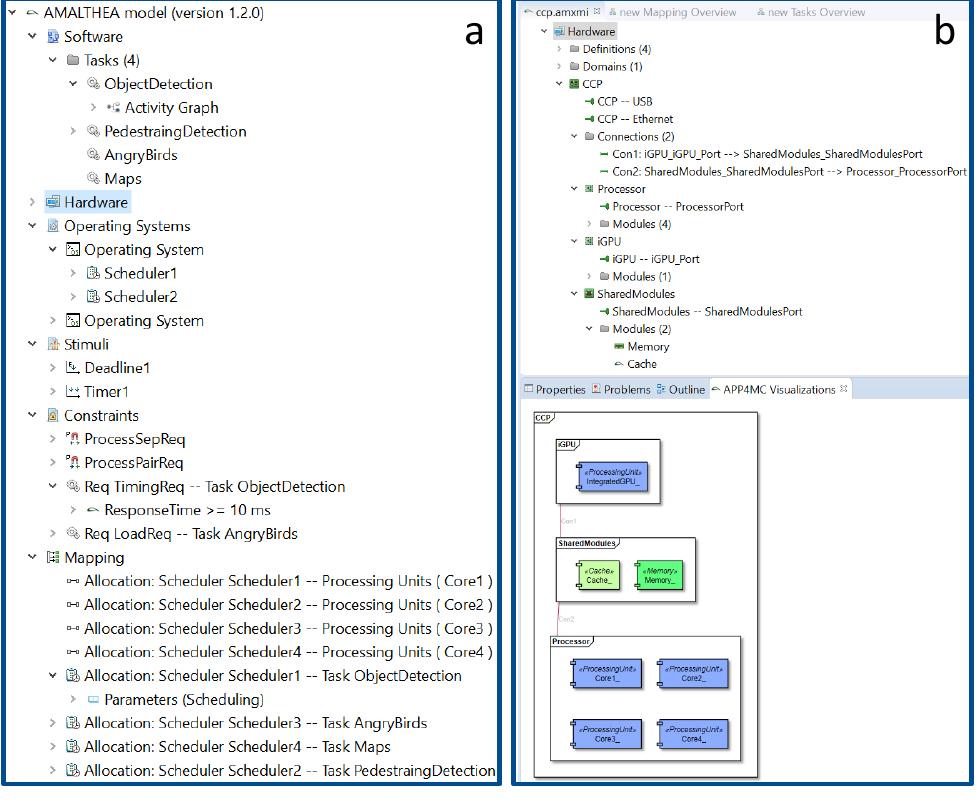
Figure 7. An automotive HW and SW system model including timing and mapping constraints ( a ), and visulization of the HW model ( b ) in APP4MC